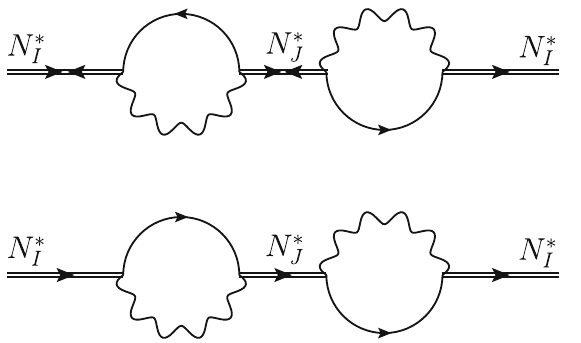
energy diagrams in Fig. 3. We show the two possible diagrams due to Majorana field contractions in each row